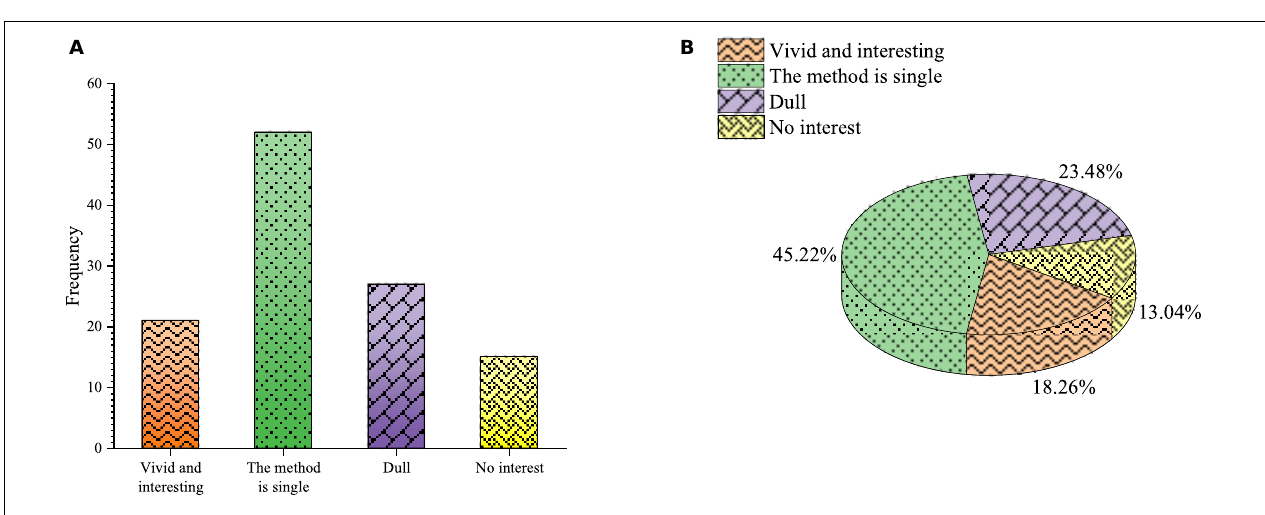
FIGURE 12 | Students’ feelings in the entrepreneurial education (A) frequency (B)